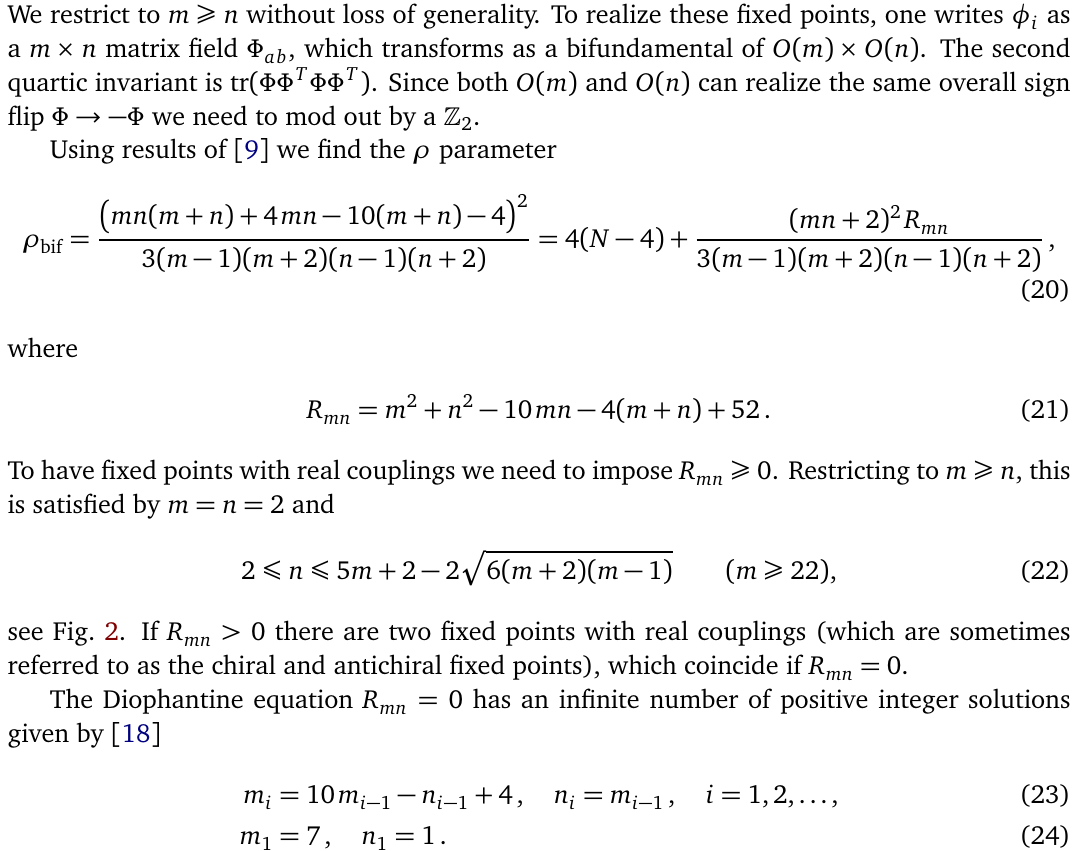
Figure 2: The region of ( m , n ) space satisfying the conditions m (cid:190) n (cid:190) 2, R needed to have bifundamental fixed points with real couplings. It consists of the point m = n = 2, and of the integer points in the gray region, described by Eq. (22). Notice that the allowed region around point m = n = 2 is really a tiny triangle invisible on this scale, but m = n = 2 is the only integer point within